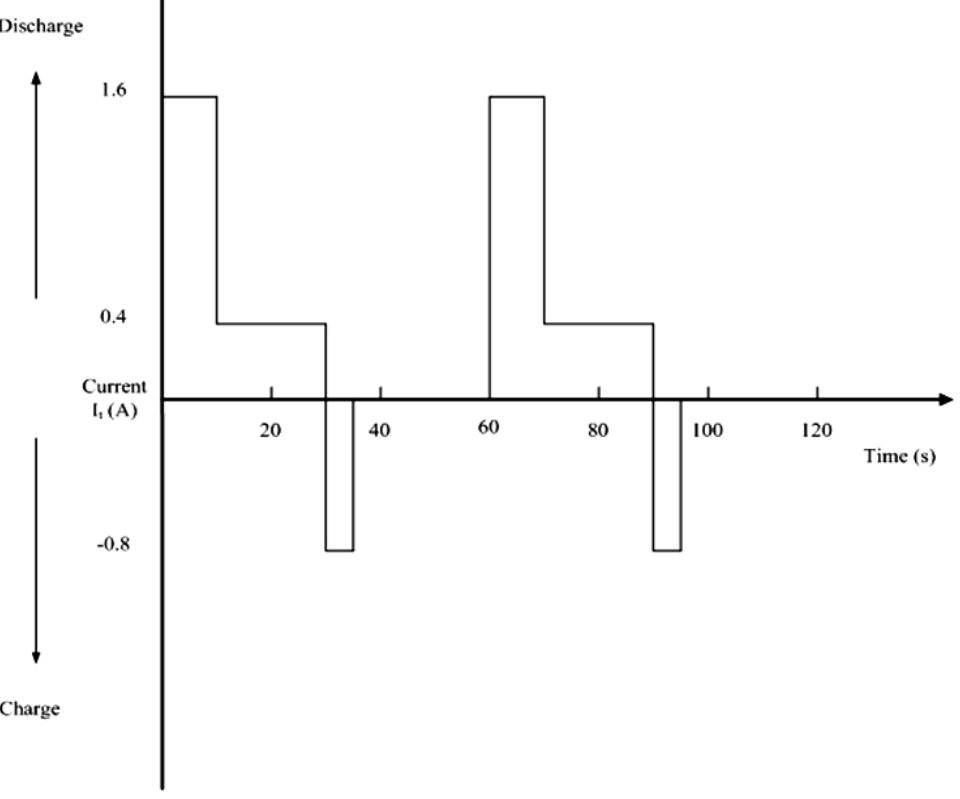
Figure 4. Dynamic Discharge Performance Test